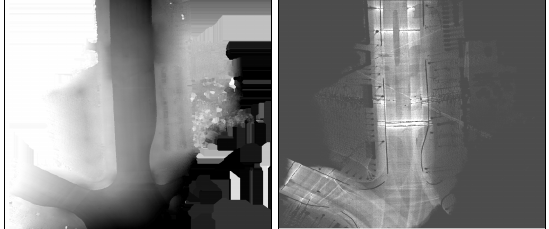
Figure 11. Left: Height image. Right: Density image.